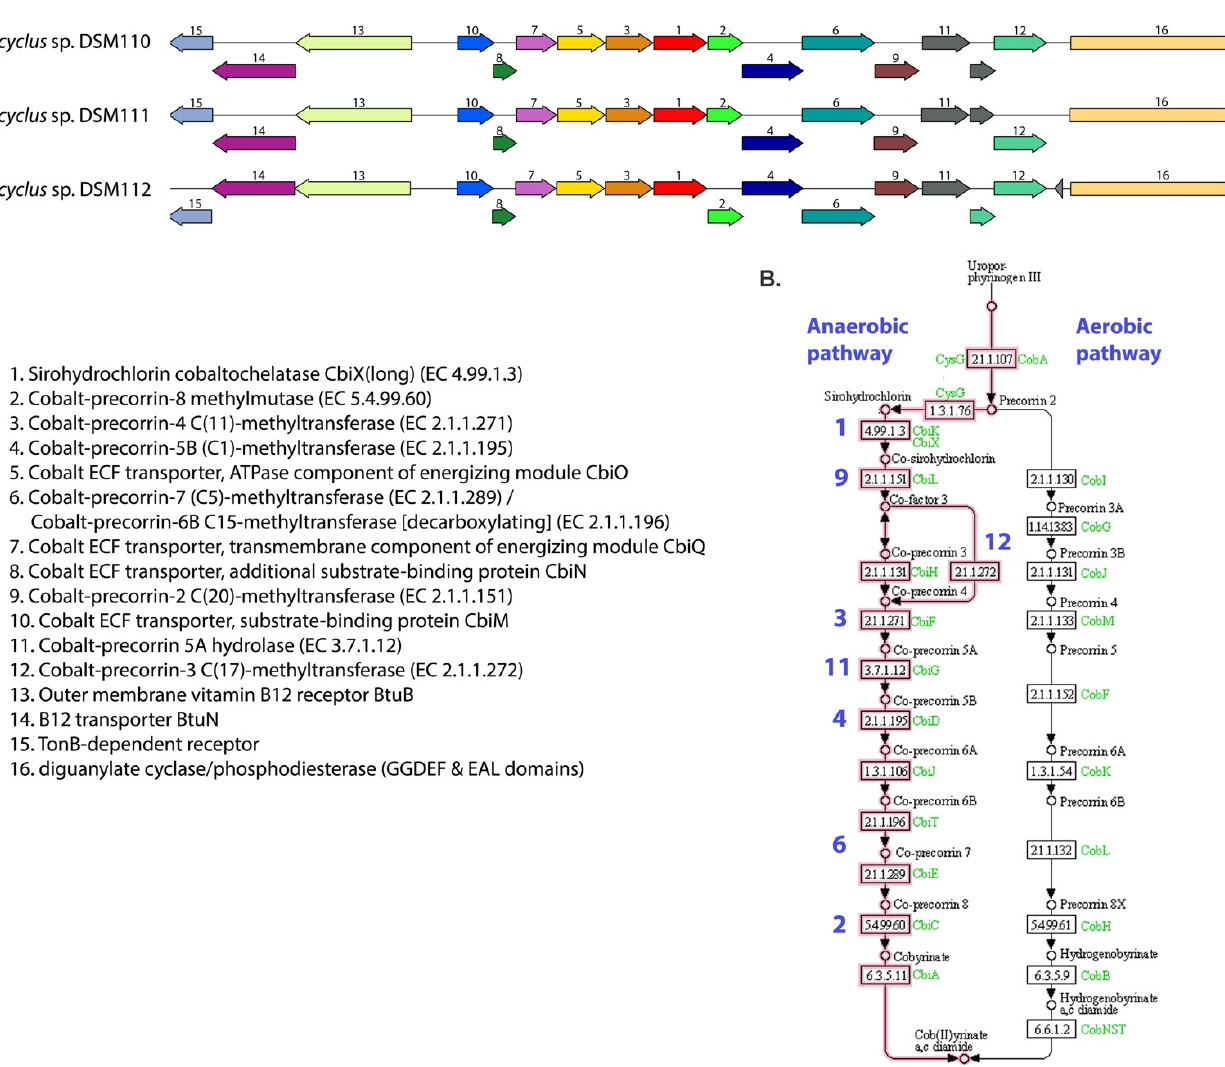
Figure 5. ( A ). Overview of the anaerobic cobalamin genetic pathway that was found in Rhodocyclus strains DSM 110, DSM 111, and DSM 112. Synteny plots were generated in PATRIC [22] and genes are colored based on enzymatic family. ( B ). Overview of the anaerobic and aerobic cobalamin metabolic pathways. Enzyme numbering is the same as corresponding gene numbers in ( A ).